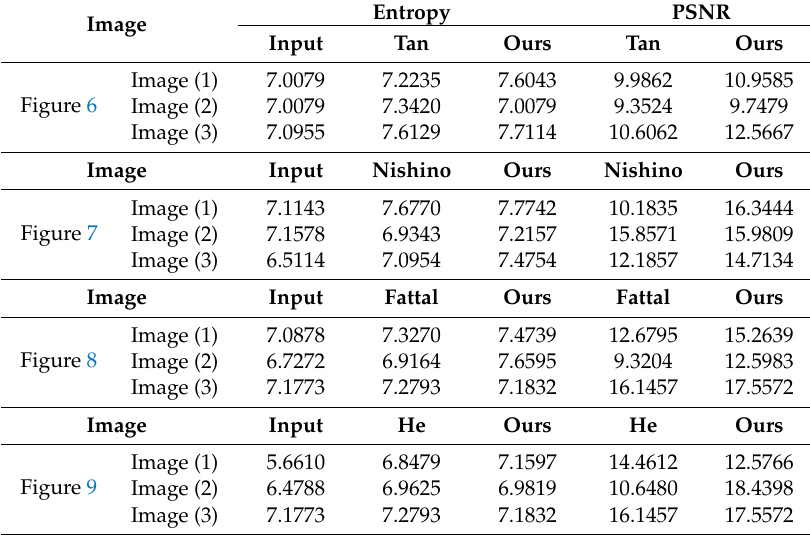
Table 1. Comparison of entropy and Peak Signal-to-Noise Ratio (PSNR) on the real-world image for each algorithm compared.